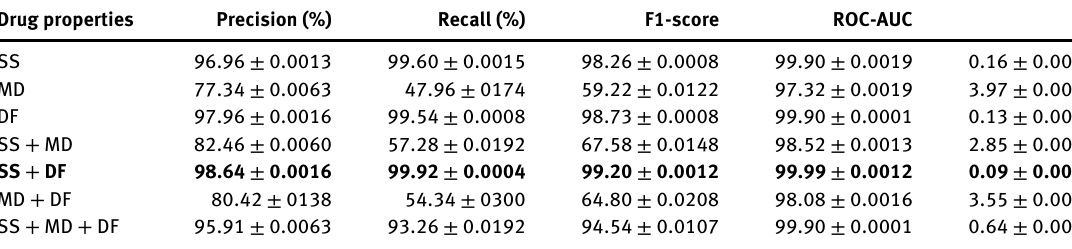
Table 2: Performance of the proposed methodology. Drug properties Precision (%) Recall (%) F1-score ROC-AUC HL SS 96.96 ±